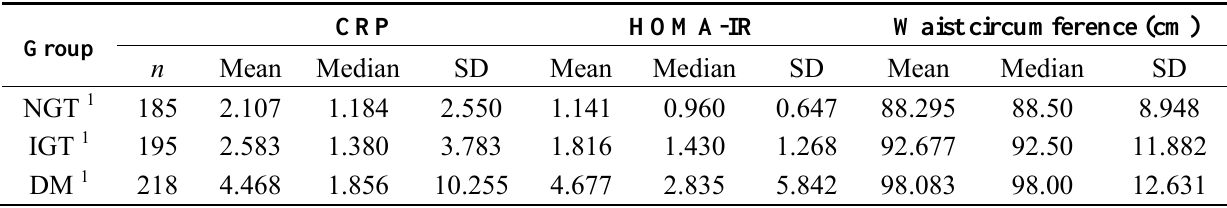
Table 5. Descriptive statistics for C-reactive protein (CRP), insulin resistance (HOMA-IR) and waist circumference.